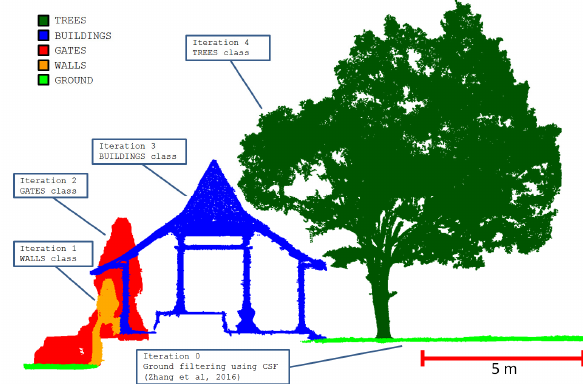
Figure 7. A profile of Siti Inggil illustrating the segmented classes and the ordering of the use of the shapeseg function, starting from lower objects to higher ones. Note that the TREES class is not discussed in this paper.